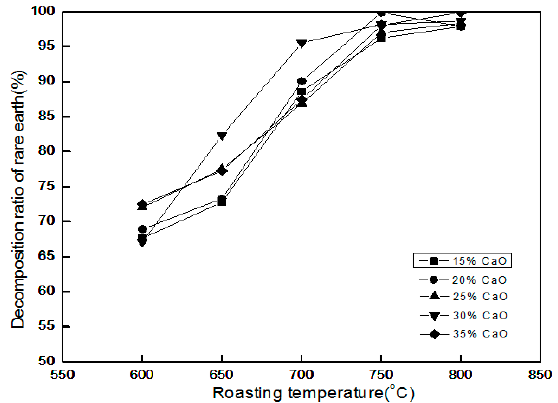
Figure 5. Effect of roasting temperature on the decomposition rate of REE at different levels of CaO addition.